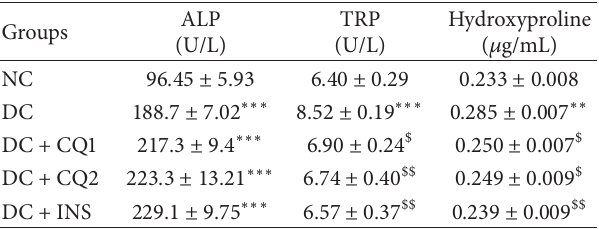
Table 2: Effects of PECQ on serum bone markers in diabetic